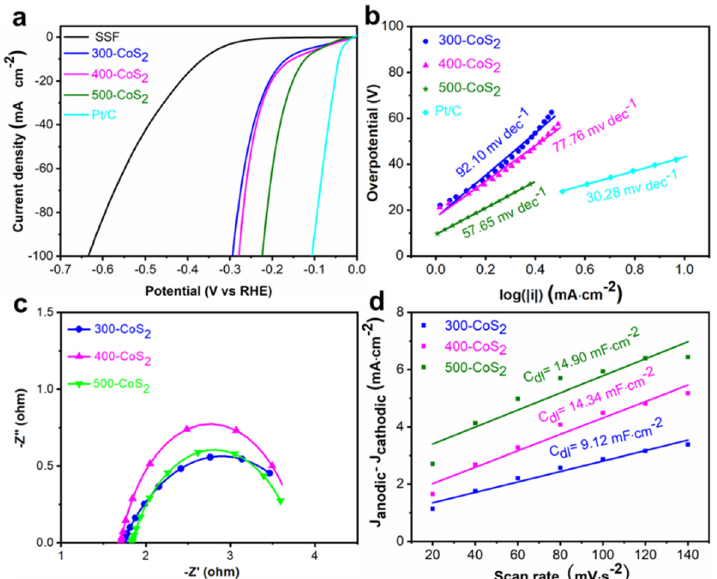
Figure 4. CoS 2 /SSF at different vulcanization temperatures. ( a ) The LSV diagram; ( b ) the Tafel slope diagram; ( c ) the Nyquist diagram; and ( d ) the C dl plots.